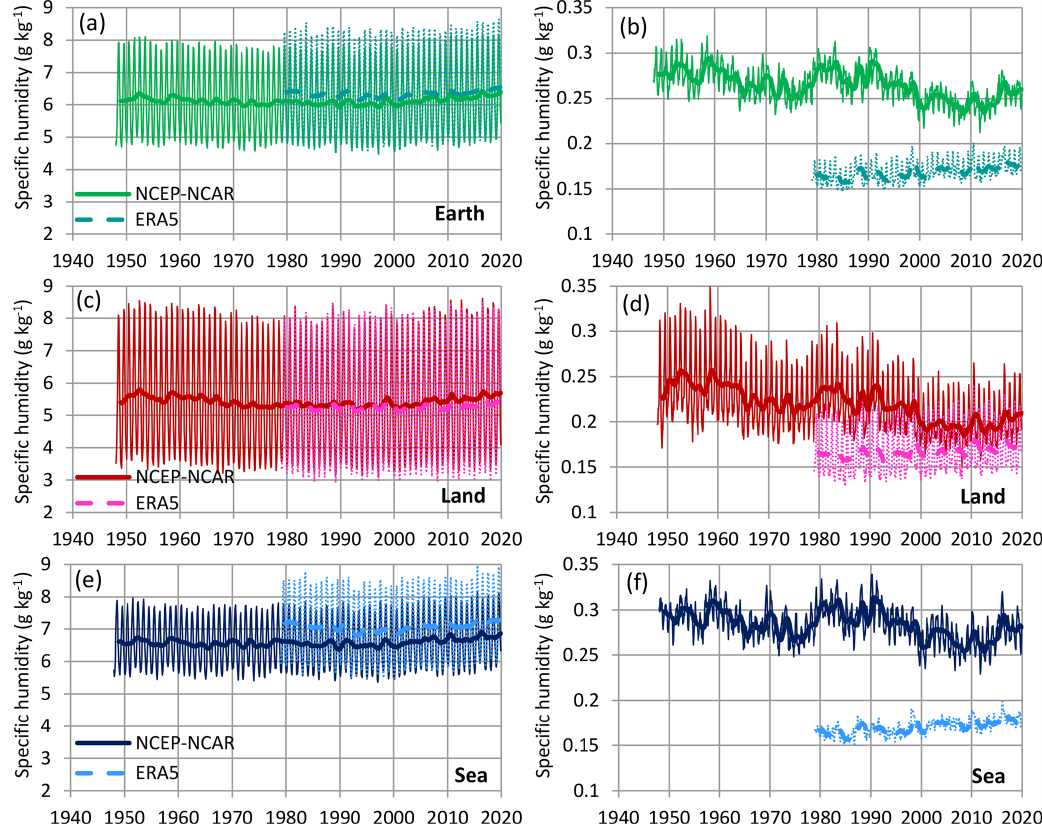
Figure 5. Variation of specific humidity at the levels of (a, c, e) 850hPa and (b, d, f) 300hPa. Thin and thick lines of the same colour represent monthly values and running annual averages (right aligned), respectively. Sources of the data are indicated in the legend and detailed in Table